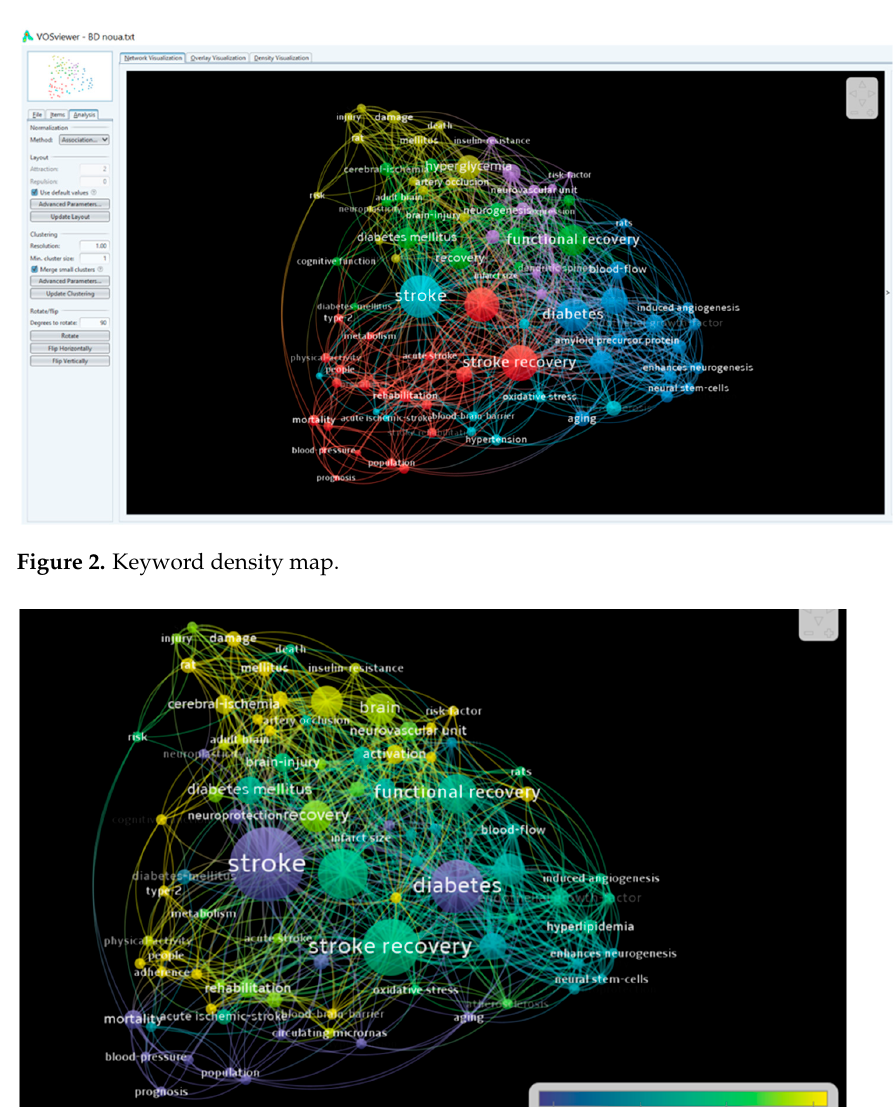
Figure 1. Authors, visual map according to number of publications.